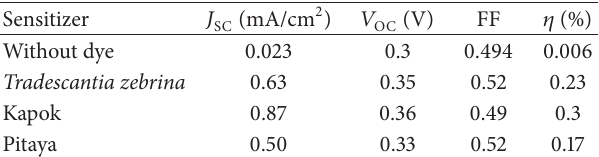
Table 1: Photoelectrochemical parameters of DSSCs sensitized with three kinds of natural dyes, compared with the solar cell without dye sensitization.